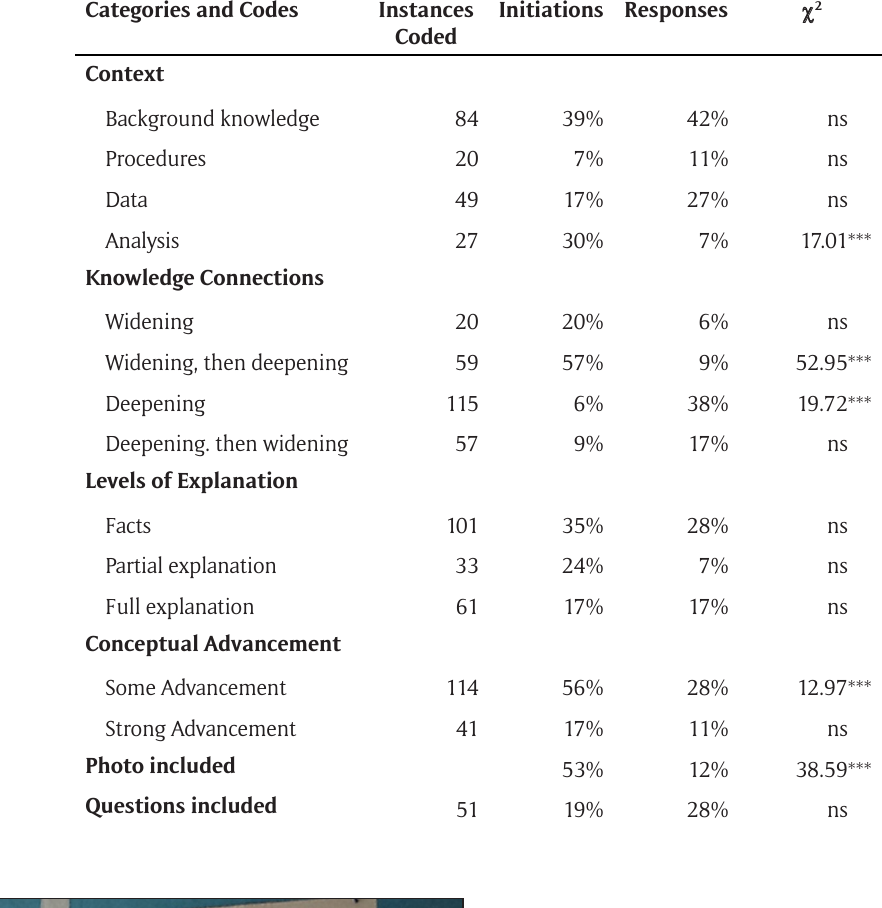
Table 2: Use of Context and Knowledge-Building Codes to Initiate and Respond to Online Discourse.